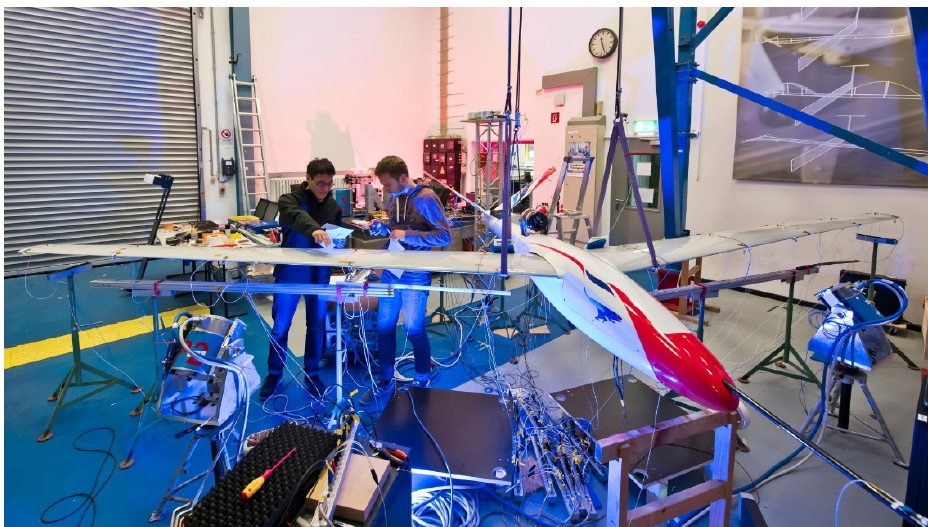
Figure 15. GVT of the FLEXOP aircraft.